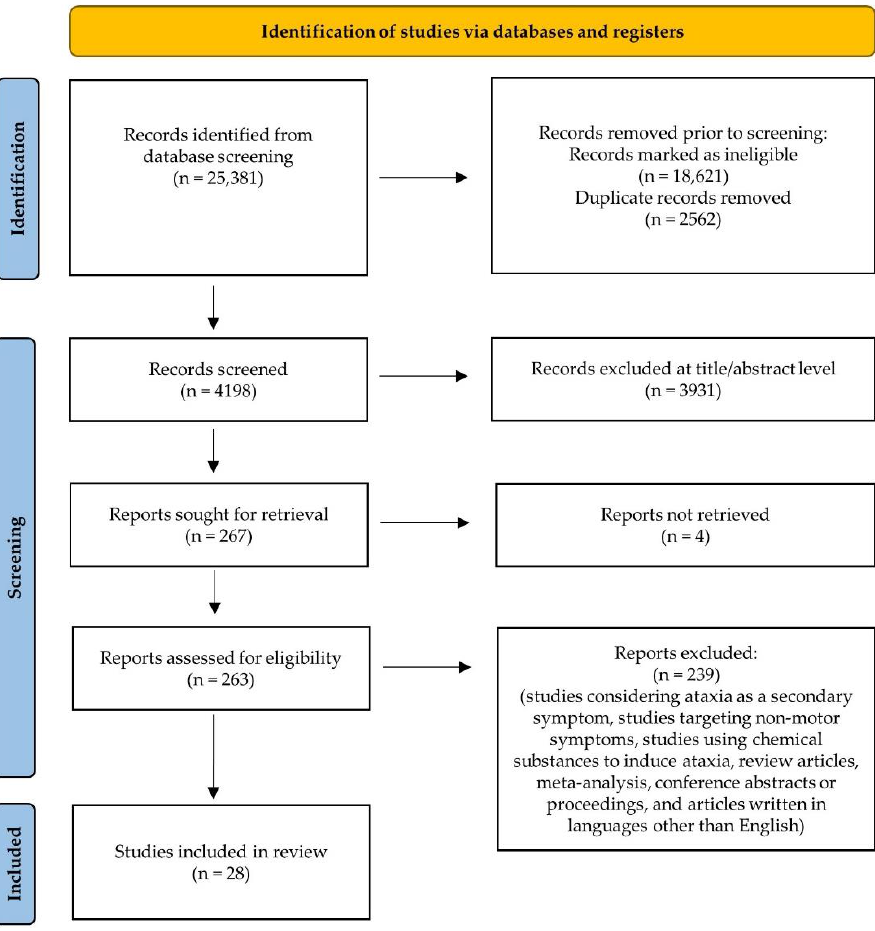
Figure 6. PRISMA flow chart for the identification of relevant studies.